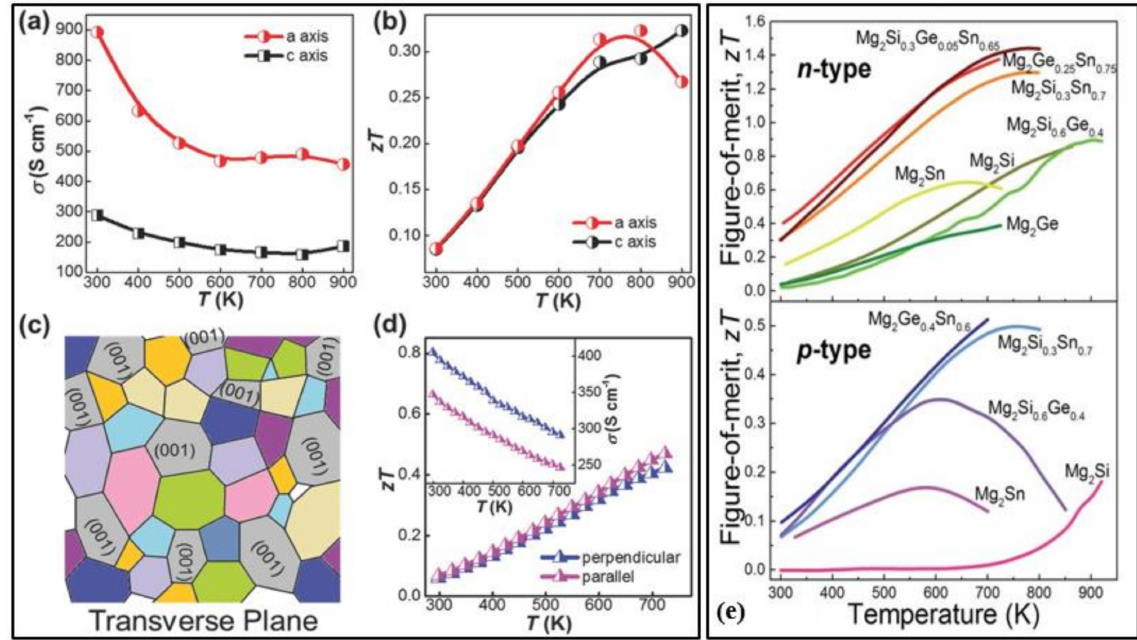
Figure 7. ( a ) Electrical conductivity ( σ ) of higher manganese silicide (HMS) crystal. ( b ) The estimated dimensionless figure of merit (ZT) of HMS single crystal. ( c ) Schematic diagram of anisotropy of as-sintered HMS pellets in the transverse plane. ( d ) ZT of as-sintered HMS pellet perpendicular and parallel to pressing direction, respectively, inset showing σ along with the two directions, Reproduced with permission from [84]. Copyright © 2018, Wiley Online Library. ( e ) Temperature depen- dence of figure of merit (ZT) of p-type magnesium-based thermoelectric materials (Mg 2 Ge, Mg 2 Sn, Mg 2 Si, Mg 2 Si 0.6 Ge 0.4 , Mg 2 Si 0.3 Sn 0.7 , Mg 2 Ge 0.25 Sn 0.75 , and Mg 2 Si 0.3 Ge 0.05 Sn 0.65 ) and n-type magnesium-based thermoelectric materials(Mg 2 Sn, Mg 2 Si, Mg 2 Si 0.6 Ge 0.4 , Mg 2 Si 0.3 Sn 0.7 , Mg 2 Ge 0.4 Sn 0.6 ), Reproduced with permission from [85]. Copyright © 2018, Royal Society of